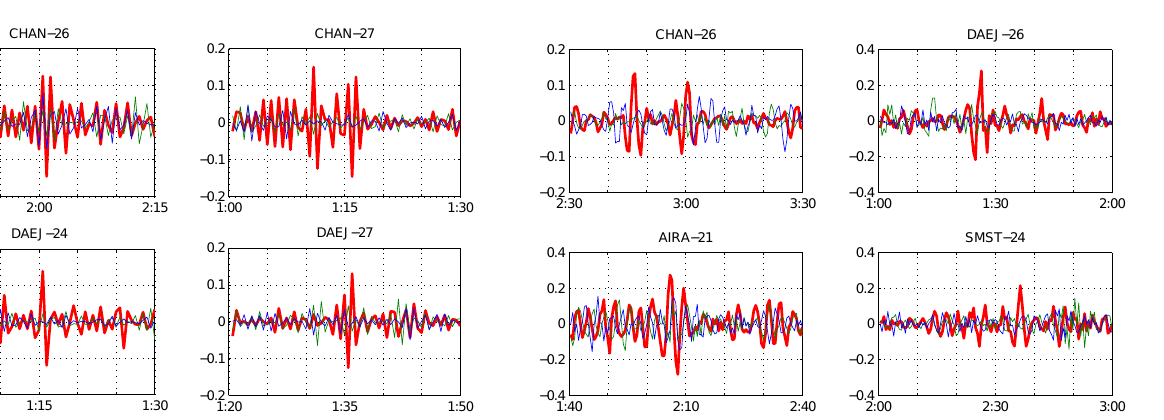
Figure 6. The extracted disturbance series containing the low- frequency TIDs at different stations for 3-day data. The abscissa represents the UT time and the ordinate represents the disturbance series with unit of TECU. The title for every panel is composed of station ID and satellite PRN number. The bold red line indicates the series on event day and the green and blue for the former day and the latter day,